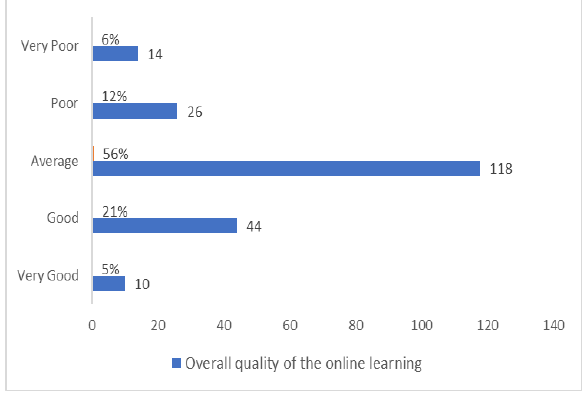
Figure 3 <Evaluation of Overall Quality of Online